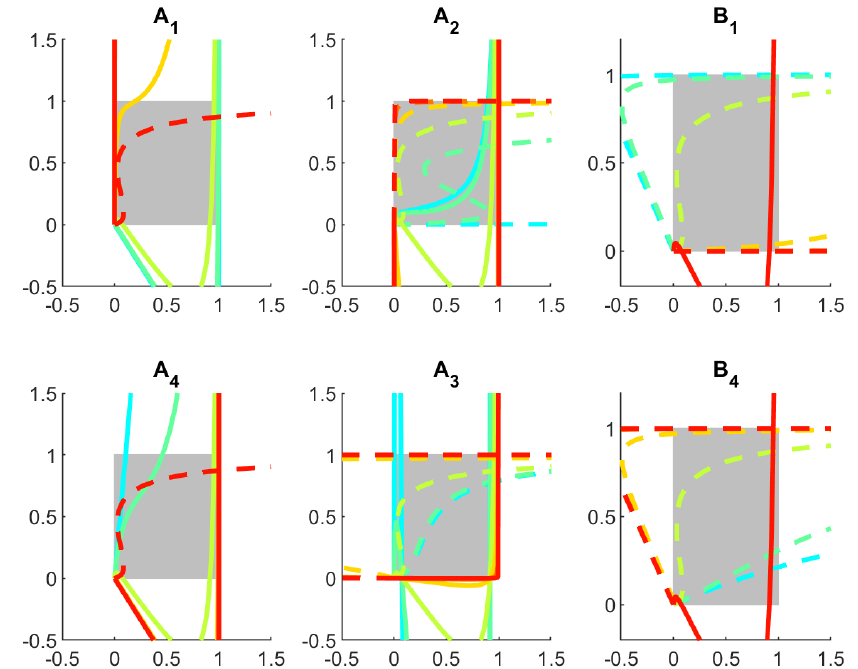
Figure A2. By larger variation in the individual parameter values by factors 10 − 2 ,10 − 1 ,1,10 1 ,10 2 and 10 3 of their default values, the effects on the nullclines and the steady states are observed. Pairwise nulclines have the same color code while the X nullclines are full curves and the Y nullclines are stipulated while the grey square represents the physiologically feasible states. Note that the pairwise nullclines at most have three intersections whereof at most two correspond to stable steady